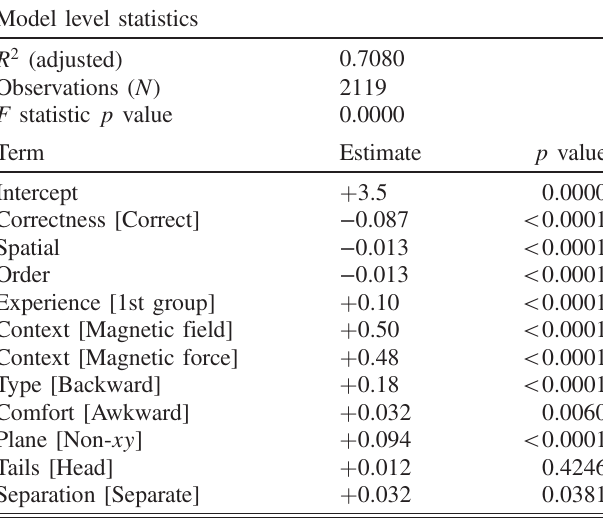
TABLE III. Least squares regression for Log (T). A positive estimate indicates that the category in square brackets contributed to a longer response time than the other category associated with that term. For example, the positive estimate for Type [Backward] implies that Backward problems took more time than Forward problems, whereas the negative estimate for Correctness [Cor- rect] implies that Correct problems took less time than Incorrect problems.